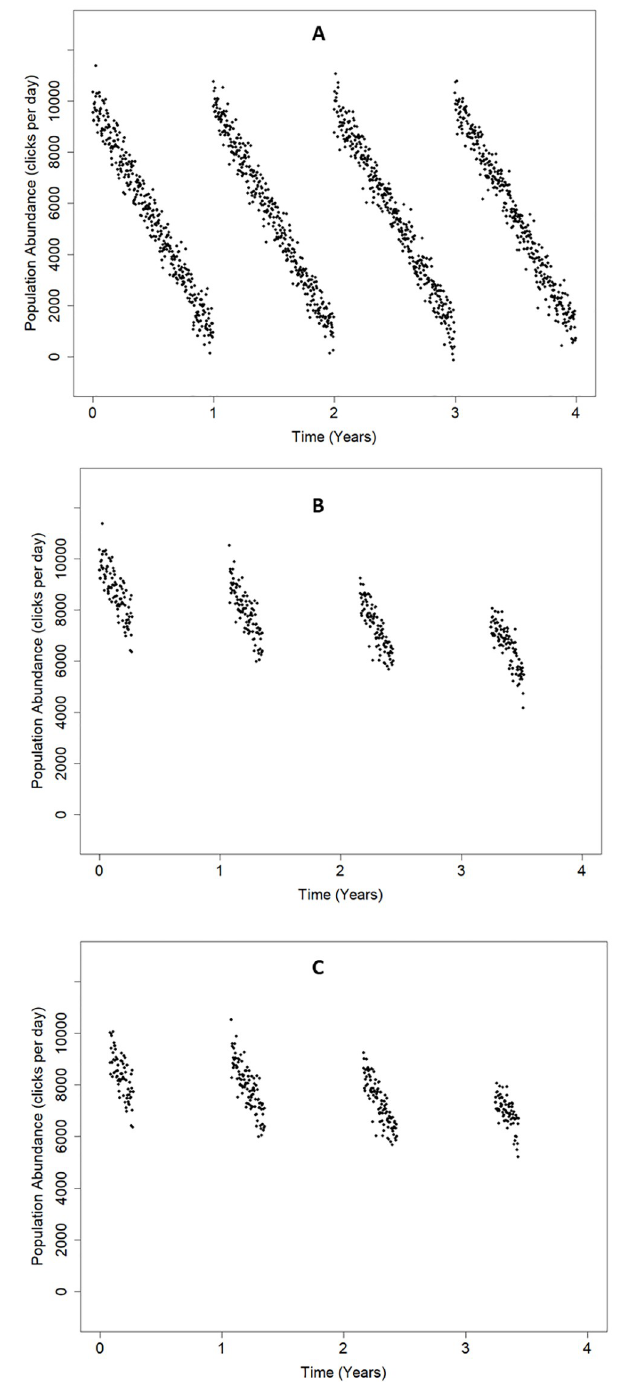
Fig 1. Scenario 1: ‘Seasonal’ detection pattern with no long-term trend. (A) complete data , (B) incomplete data and (C) paired data . The downward trend visible in (B) and (C) is a spurious outcome of the incomplete sampling which illustrates the type of problem that population trend estimation from incomplete data needs to